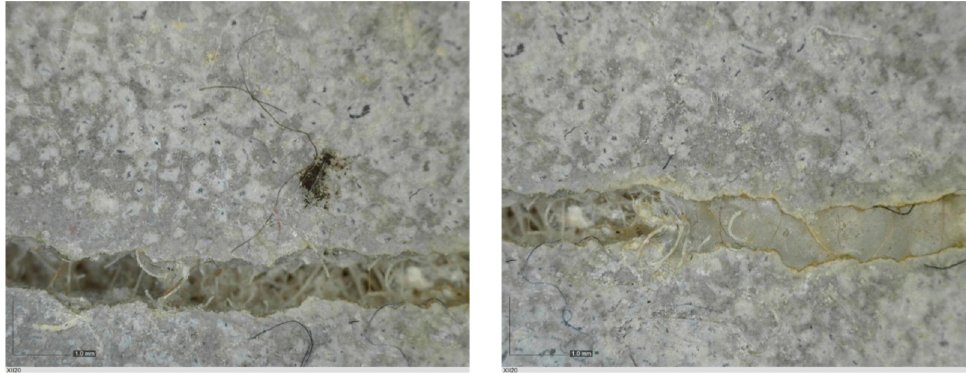
Figure 16. Cracks were healed by formations growing from the crack boundary surfaces (50× zoom). Materials 2020 , 13 , x FOR PEER REVIEW